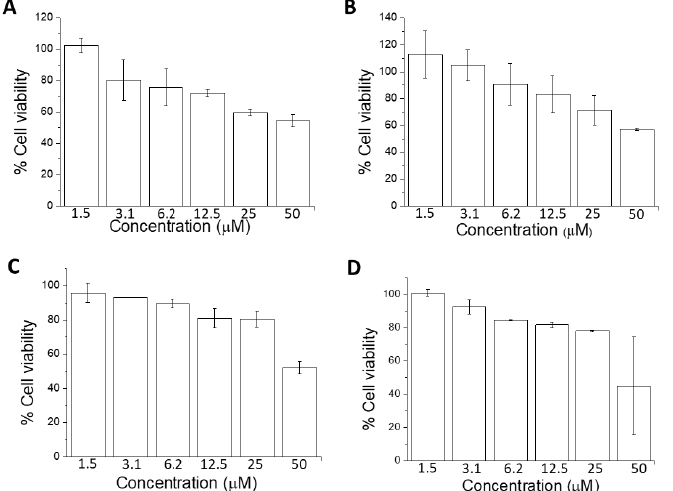
Figure 3. Cell viability of U-937 cells. PMA-treated U-937 cells with chlorogenic acid ( A ), oleuropein ( B ), α -tomatine ( C ), and tyrosol ( D ) at different concentrations. Data are presented as mean ± SE.